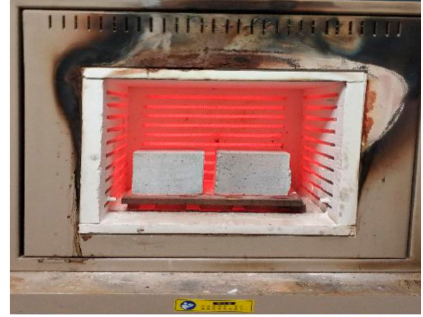
Figure 3. Specimens in an electrically controlled